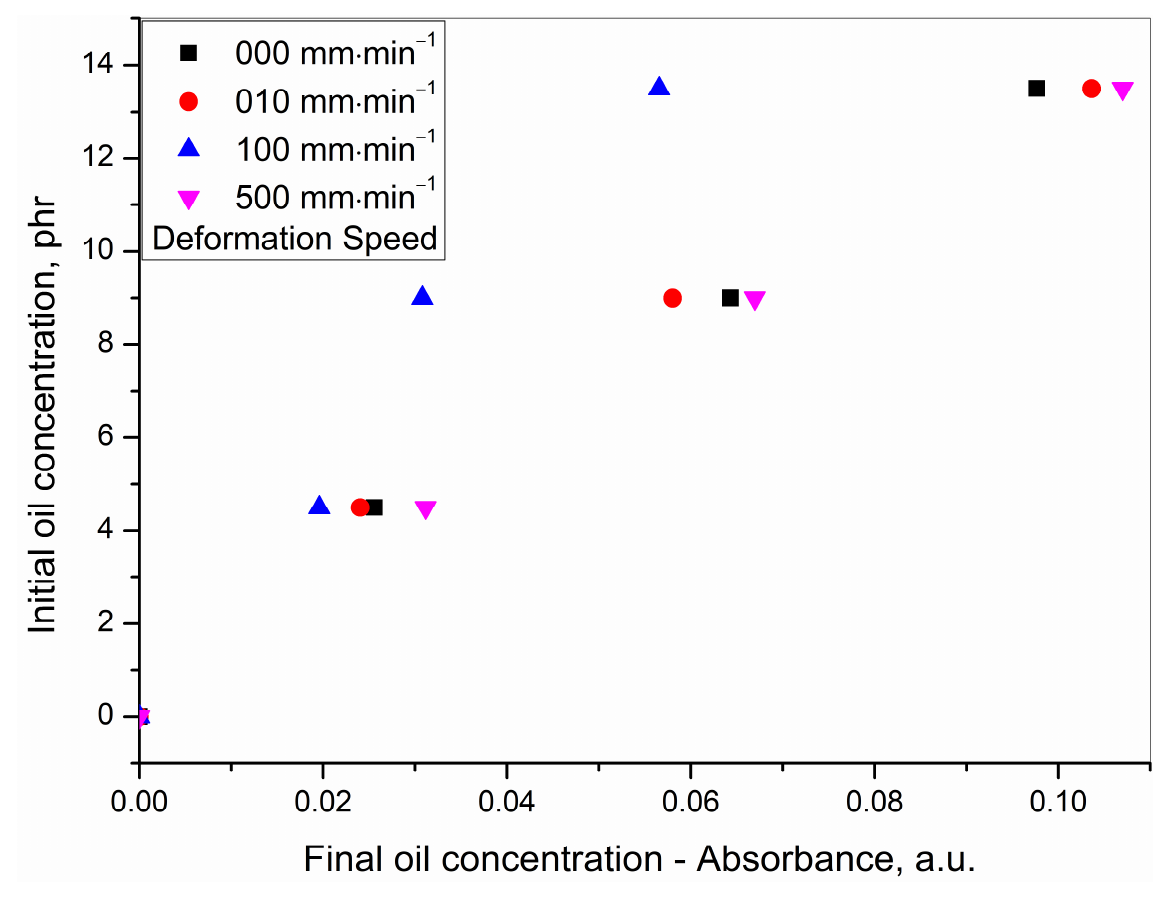
Figure 8. Initial oil concentration for various tensile ruptured programmes against redistributed oil concentration as obtained from experimental results.